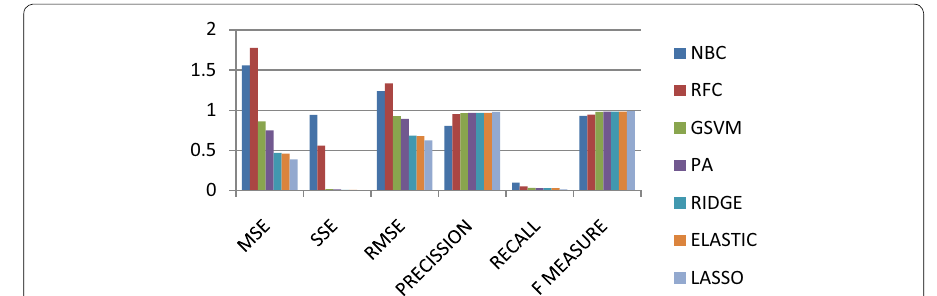
Fig. 2 Performance metrics for different classifiers under FG-NET